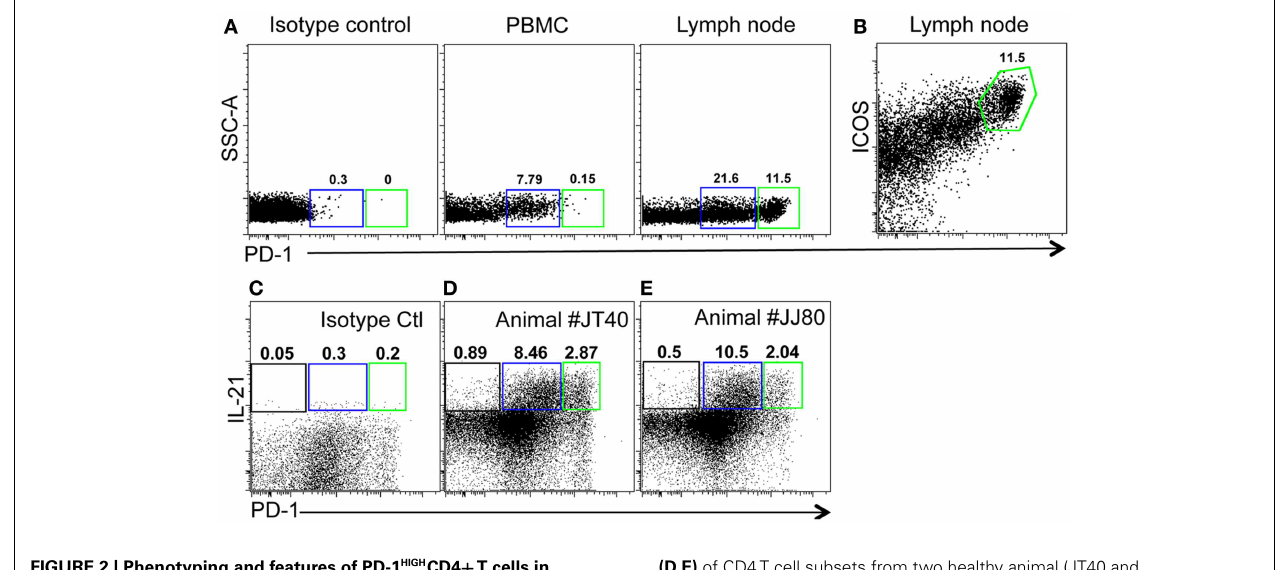
FIGURE 2 | Phenotyping and features of PD-1 HIGH CD4 + T cells in blood and mesenteric lymph nodes of adult rhesus macaques . (A) Representative plots of PD-1 HIGH CD4T cells in PBMC and lymph node. (B) High co-expression of ICOS on PD-1 HIGH cells gated through CD4 + cells in lymph nodes. (C) Isotype control and IL-21 secretion